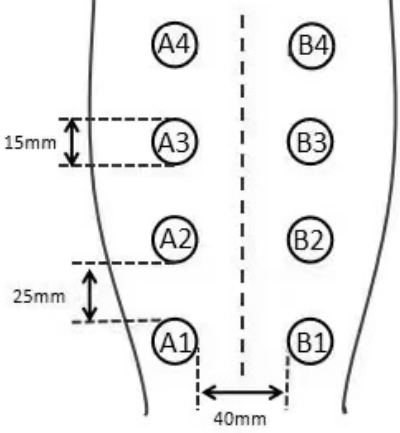
Figure 1. Four circular wounds with a diameter of 15 mm on each side of the midline of the shaved dorsum. Each wound is 20 mm from the midline of the dorsum, and the adjacent wounds are 25 mm from each other. From the tail side to the head side, and from left to right, the wounds are labeled in the following order: A1, A2, A3, A4, B1, B2, B3, B4.